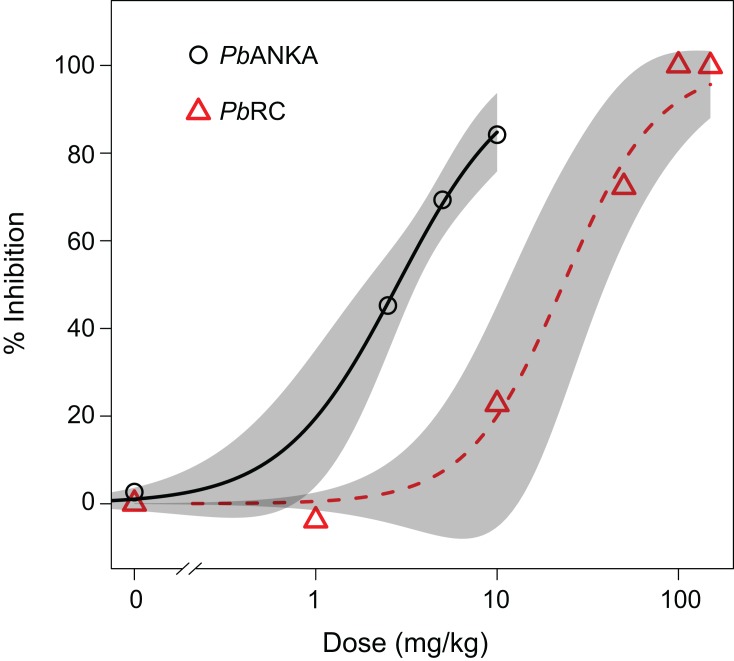
Artesunate sensitivity of P. berghei RC (PbRC) in infected mice.BALB/c mice were infected intravenously with 1 × 107 infected red blood cells. Artesunate was given orally and parasitemia was determined four days post infection. Five to six mice per group were used for PbRC and four to eight mice per group were used for PbANKA reference strain. Percent inhibition compared with untreated control (0%) was calculated for each dose of drug. Data were fitted to the two-parameter variable-slope sigmoidal dose–response equation. The average percent inhibitions for each dose are plotted, and the gray bars represent confidence regions calculated by the drc package.